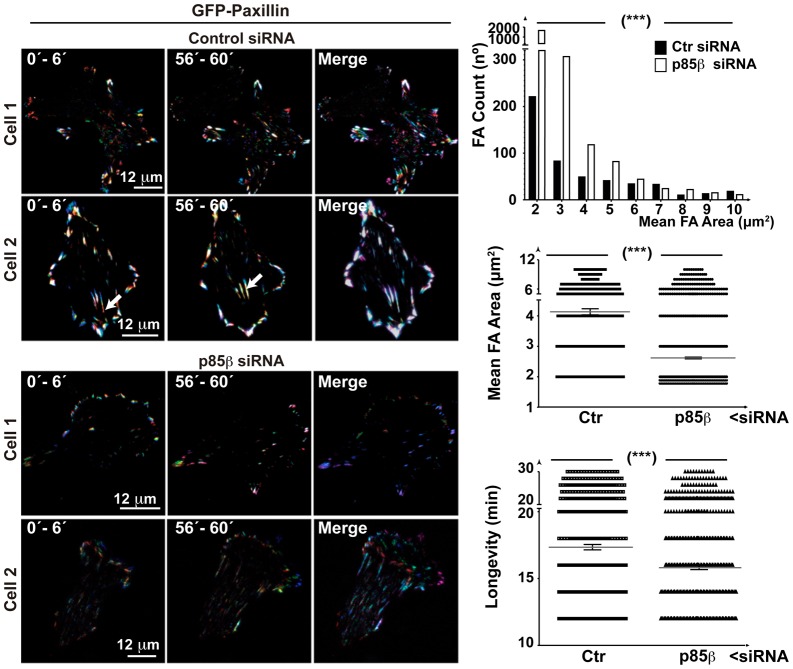
p85β mediates cell adhesion stability and maturation.BLM cells were transfected with control or p85β siRNA (24 h), then transfected with a plasmid encoding GFP-paxillin (24 h). TIRFM video microscopy was carried out at a depth of 70 nm. To evaluate the longevity and trajectory of cell adhesions, we assigned a different color to the paxillin signal collected in individual time frames and merged image sets; a white color (resulting from the mixture of colors) indicates long-lived adhesions. Left and center columns show the merge of three time points; the right column shows five time points spanning 30 frames (1 h). In control cells, some adhesions migrate to the cell center, with a parallel signal increase (indicated with an arrow). Graphs show the number of cell adhesions (top), differences in areas (center), and adhesion longevity (bottom) in n  =  12 cells in independent experiments. Mean ± s.e.m. are shown. *** P <0.001; Wilcoxon matched-pairs signed-rank test. Bar  =  12 µm.